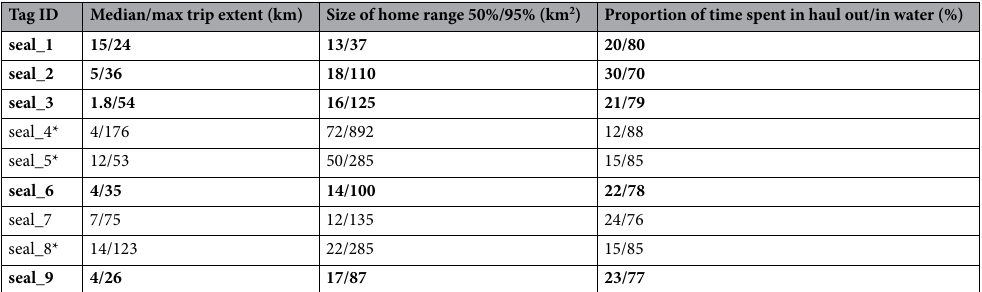
Table 2. Median/maximum trip extent, sizes of home ranges and proportion of the deployment duration spent in haul out or in the water for each individual for the full recorded period. Individuals that performed long distance trips are marked with *. Females =